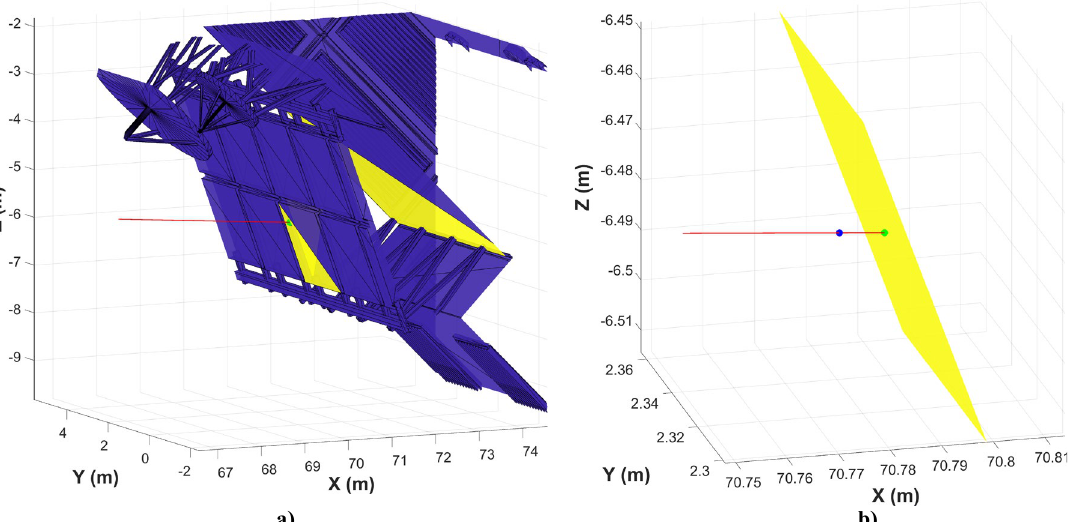
Figure 10. Intersection between the ray and the 3D model. a) Broad view of the intersection. b) Close view of the intersection. (red: ray; yellow and purple: 3D model; green: theorical intersection; blue: intersection adding the range